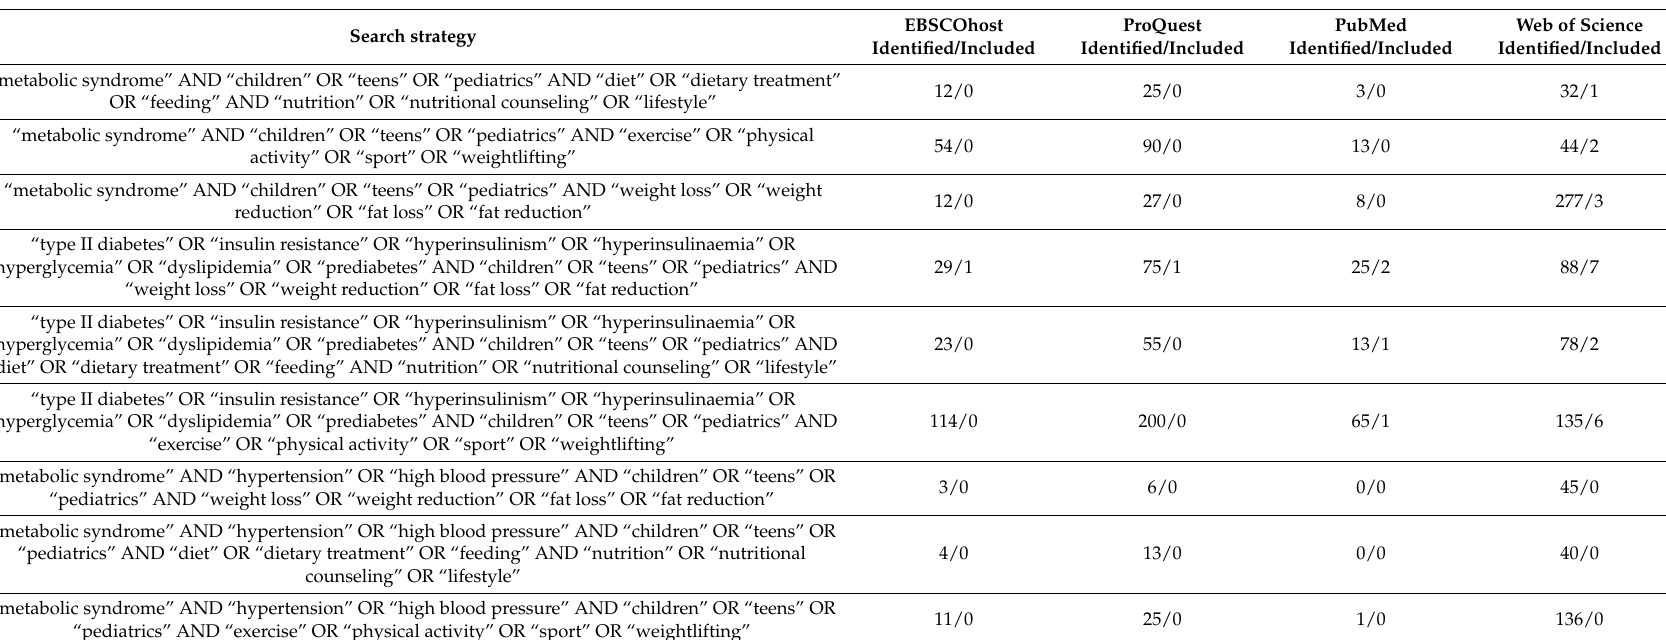
Table 5. Search strategies of identified and included clinical trials, dates: